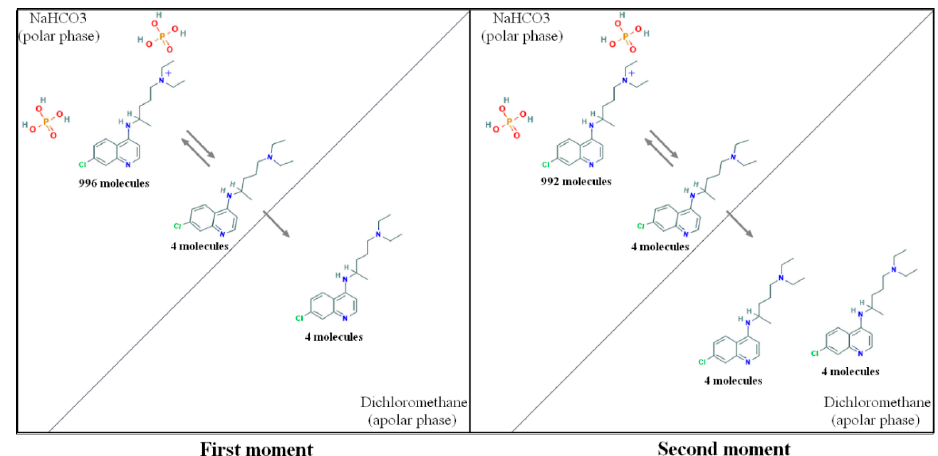
Figure 5. Suggested chloroquine partitioning scheme. At the first moment, a theoretical maximum ratio of ionized chloroquine molecules occurs in the polar phase following by a gradually partitioning to the organic phase at the second moment. This transport follows until the exhaustion with the total partition of the drug to the organic apolar phase.